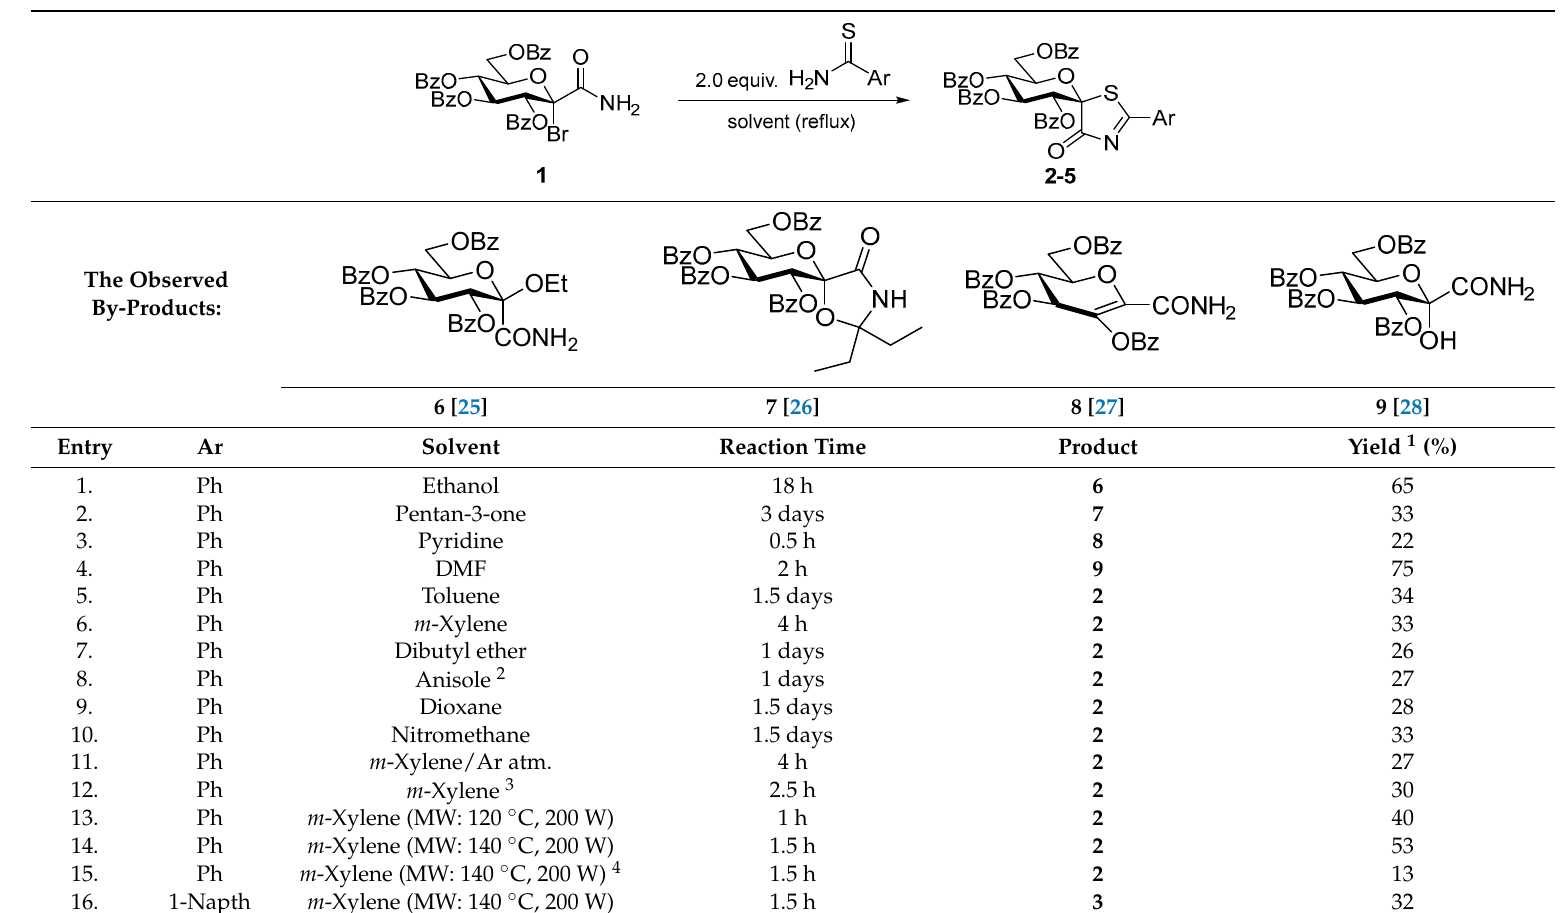
Table 1. Synthesis of spiro-thiazolinones 2 – 5 .